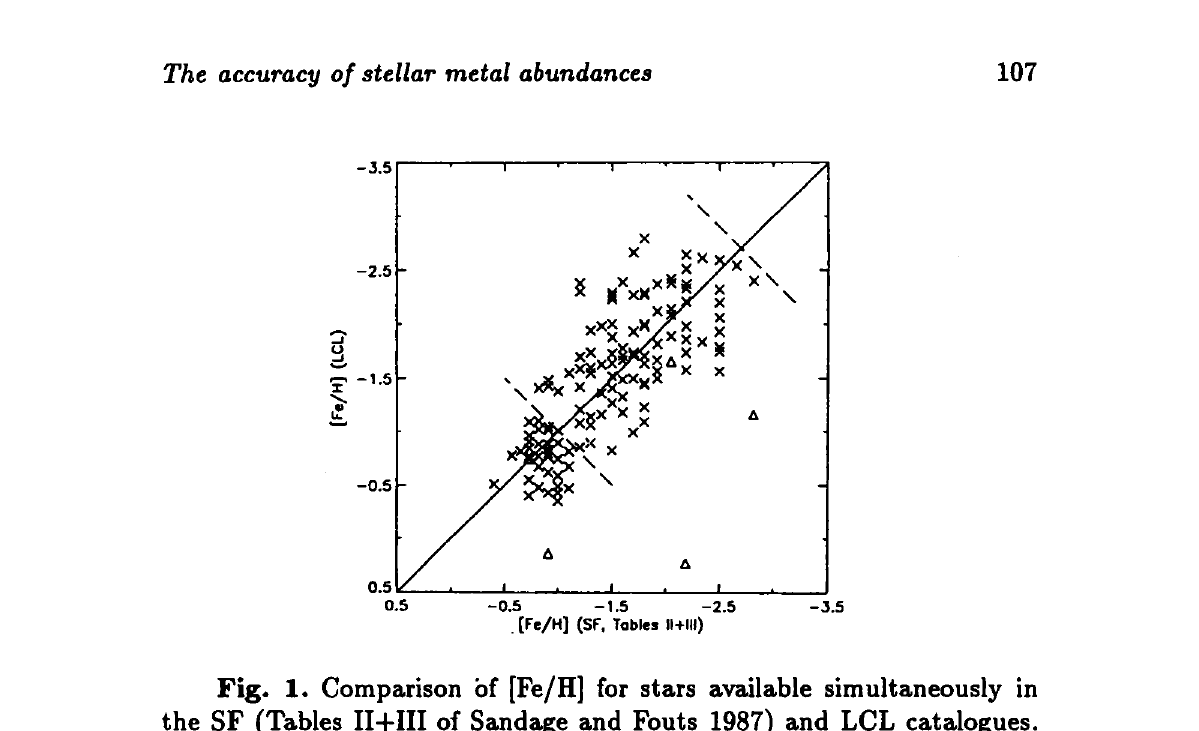
Fig. 1. Comparison òf [Fe/H] for stars available simultaneously in the SF (Tables II+III of Sandage and Fouts 1987) and LCL catalogues. Triangles denote the reddened stars with EB-V ^ 0.05 outside the interval 0.38 < B-V <0.68. The line at 45° is shown.